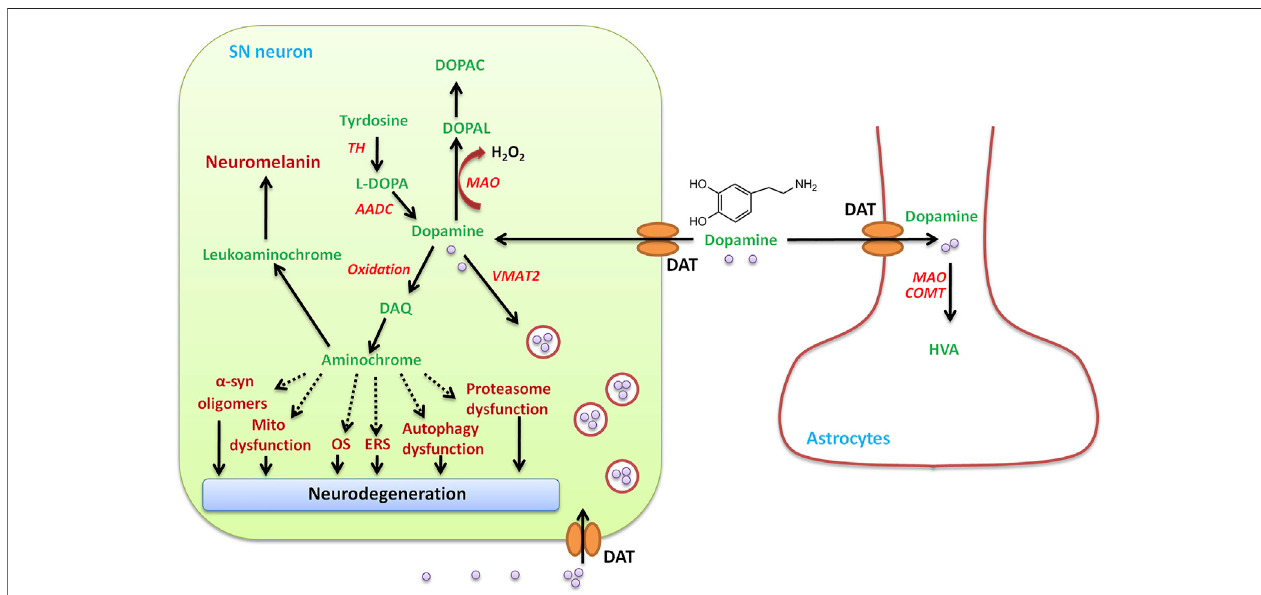
FIGURE6| SN neuron DAmetabolism. In addition to the uptake of DAby theDA transporter (DAT) from outside, DAergicneuronsin theSNproduceDAunder the action of tyrosine hydroxylase (TH) and aromatic amino acid decarboxylase (AADC) in the cytosol. The amino acid tyrosine is converted to L-dopa using TH, and the second L-dopa is converted to dopamine using AADC. The newly synthesized or taken up DA is immediately transported to and stored in the monoaminergic vesicles by VMAT-2, preventing the existence of free dopamine in the cytosol. Cytosolic DA oxidizes to dopamine o-quinone (DAQ), which is immediately cyclized to aminochrome, which induces mitochondrial dysfunction, endoplasmic reticulum stress (ERS), oxidative stress (OS), the aggregation of alpha-synuclein, and the dysfunction of protein degradation. Dopamine in the cytosol can be degraded by monoamine oxidase-mediated degradation to 3,4- dihydroxyphenylacetaldehyde (DOPAL), hydrogen peroxide, and ammonia, which is converted to 3,4-dihydroxyphenylacetic acid (DOPAC) by aldehyde dehydrogenase. DA can be taken up into glial cells and degraded by catechol-o-methyltransferase (CMOT) or monoamine oxidase (MAO) to form homovanillic acid